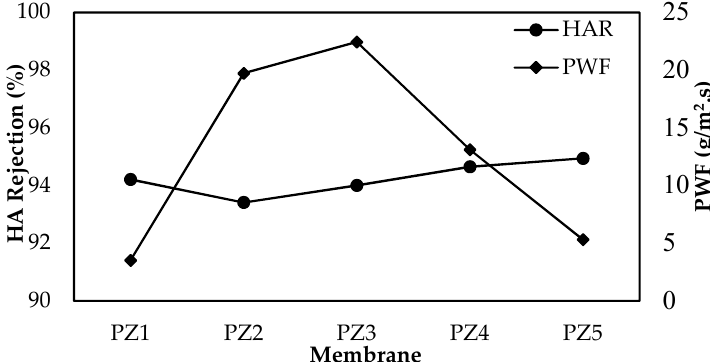
Figure 3. The trade-off graph of pure water flux (PWF) and rejection of humic acid (HA) of membrane PZ1 to PZ5.